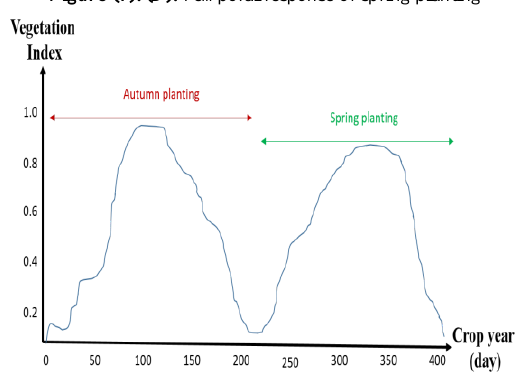
Figure (1). (B). Temporal response of spring planting